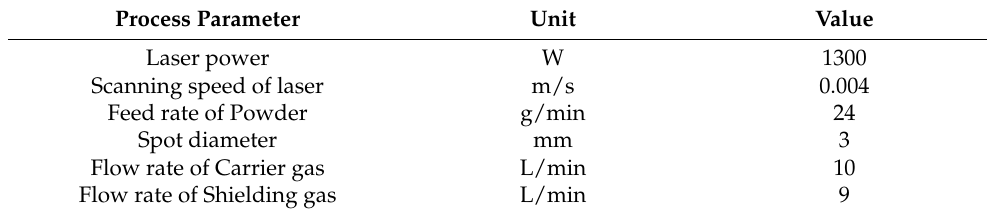
Table 4. Optimization process parameters.